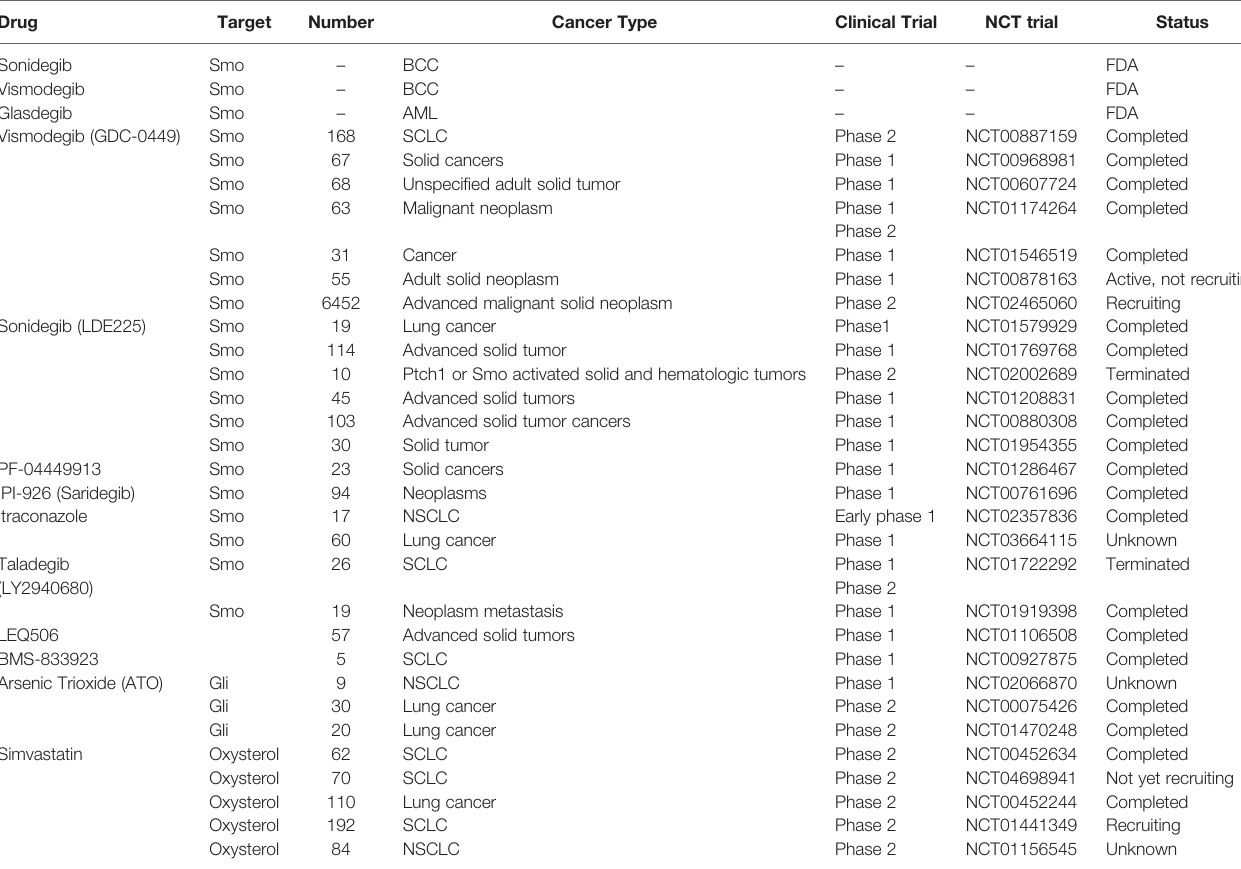
TABLE 2 | HH inhibitors in clinical trial, mainly focusing on lung cancer therapy.